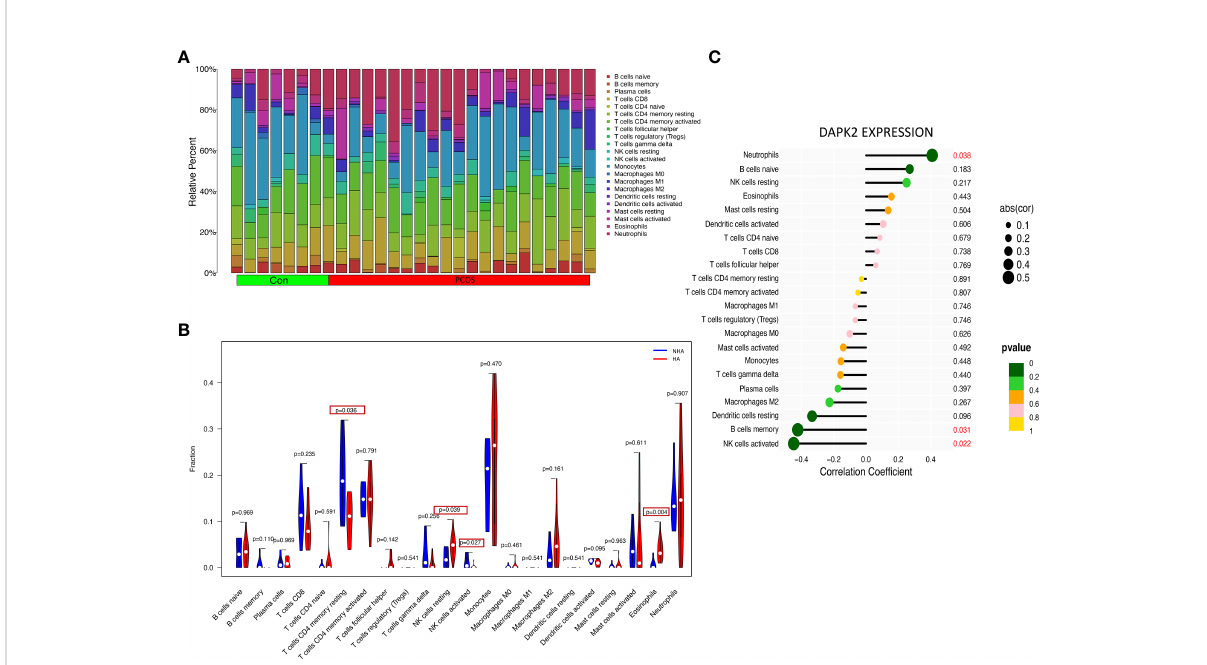
FIGURE 8 Immune cell in fi ltration analysis for PCOS. (A) The proportion of 22 immune cells in PCOS and controls. (B) The differential expression of 22 immune cells between HA PCOS and NHA PCOS. Blue was NHA PCOS group and red was HA PCOS group. p < 0.05 was framed. (C) The relationship between DAPK2 expression and immune cells. p < 0.05 was highlighted.